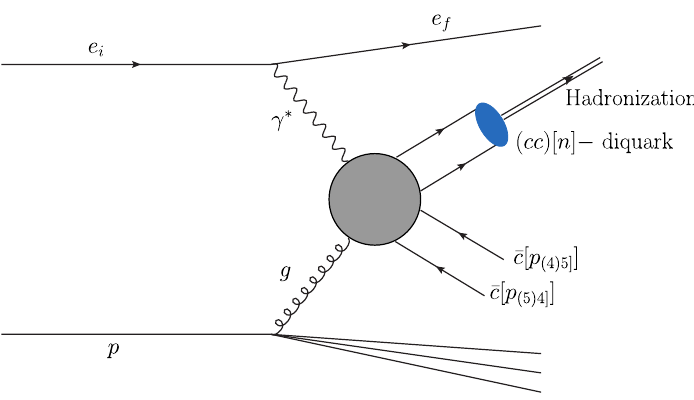
Figure 1 . The illustrative diagram for the (cid:4) cc production in deeply inelastic ep scattering. e + g ! e + (cid:4) + (cid:22) c + (cid:22) c ; and the less-important contributions from the c -quark content cc